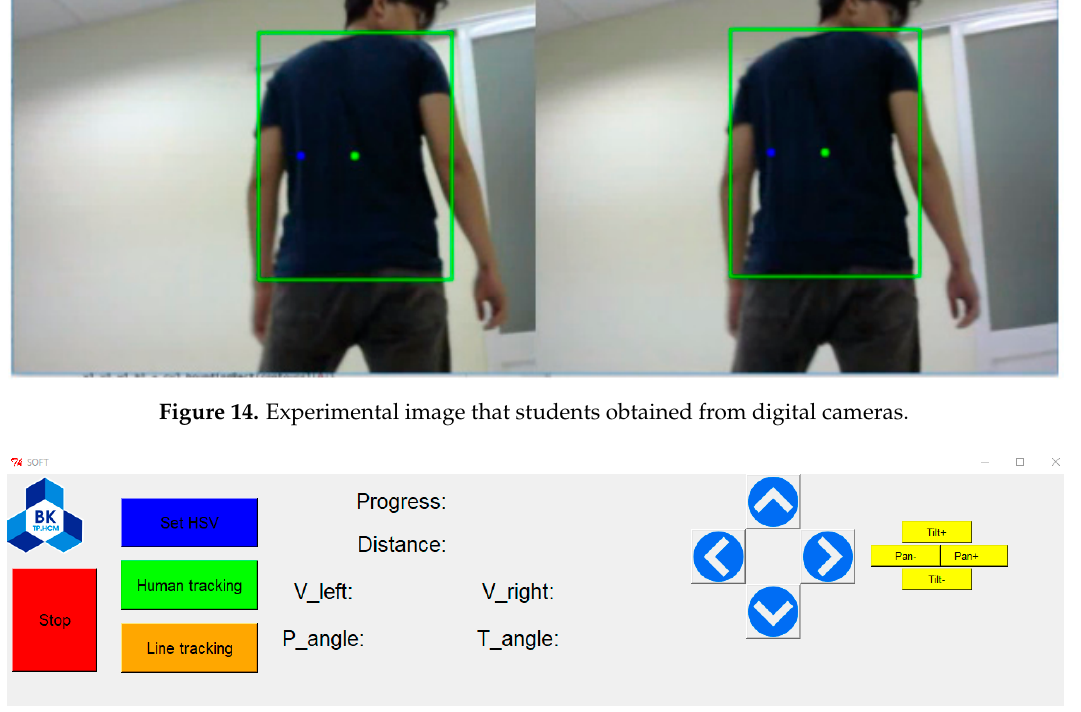
Figure 15. Student-designed interface by using the API functions in the computer.